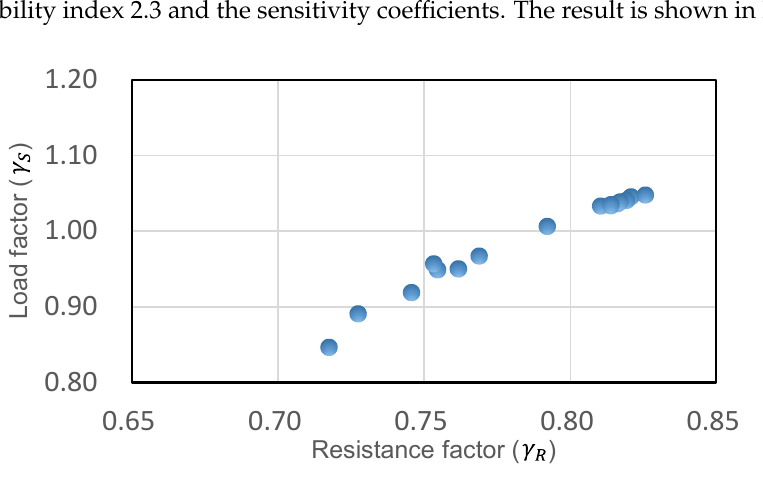
Figure 6. Sensitivities of limit state function (sliding).